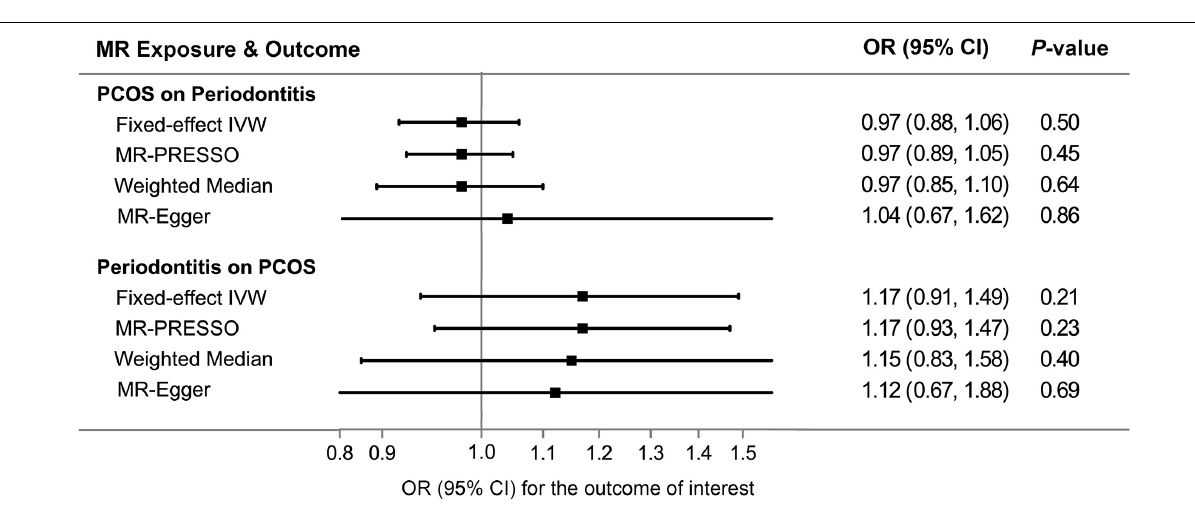
FIGURE 3 | Comparisons of Mendelian randomization results by different methods. CI, confidence interval; IVW, inverse variance weighted; MR, Mendelian randomization; OR, odds ratio; PCOS, polycystic ovary syndrome; PRESSO, pleiotropy residual sum and